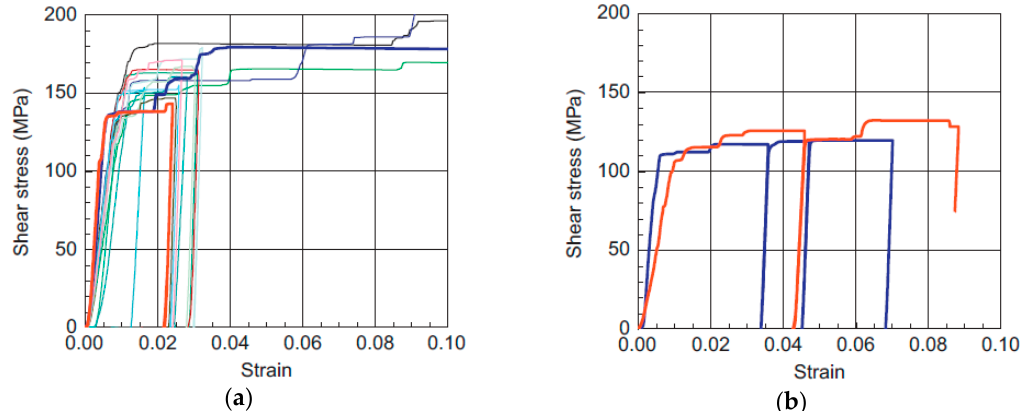
Figure 2. Example of ( a ) 5 µm and ( b ) 15 µm pillars cut within large grains, and ( c ) deformed large pillar after compression testing, reproduced from [11], with permission from Elsevier, 2013.